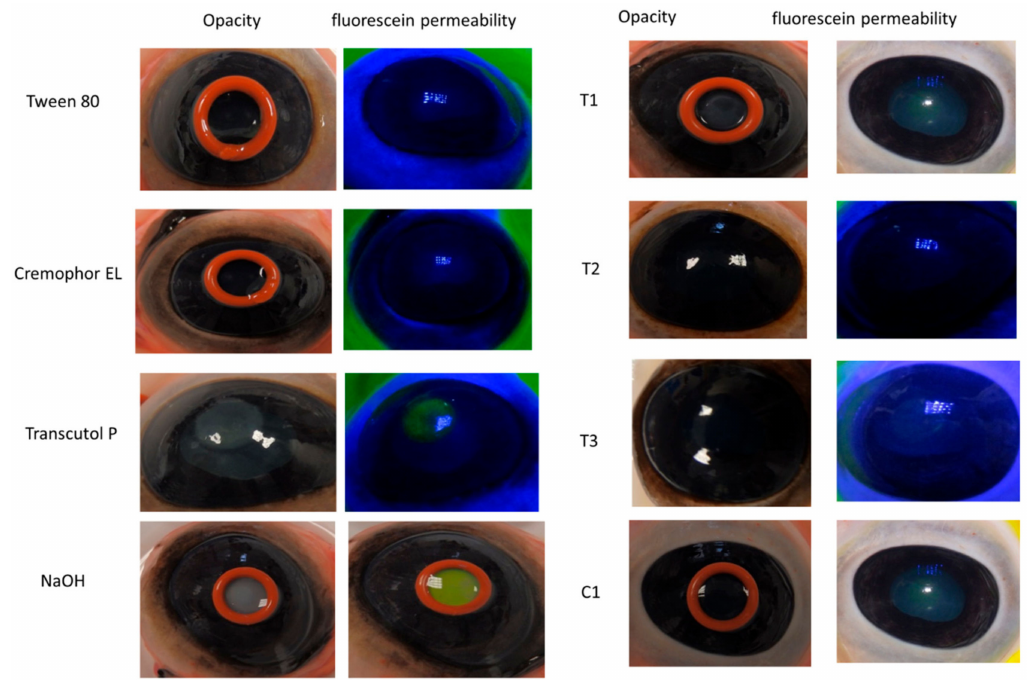
Figure 8. Degree of corneal opacity and fluorescein permeability for Tween 80, Cremophor EL, Transcutol P, NaOH and the microemulsion formulations; T1, T2, T3 and